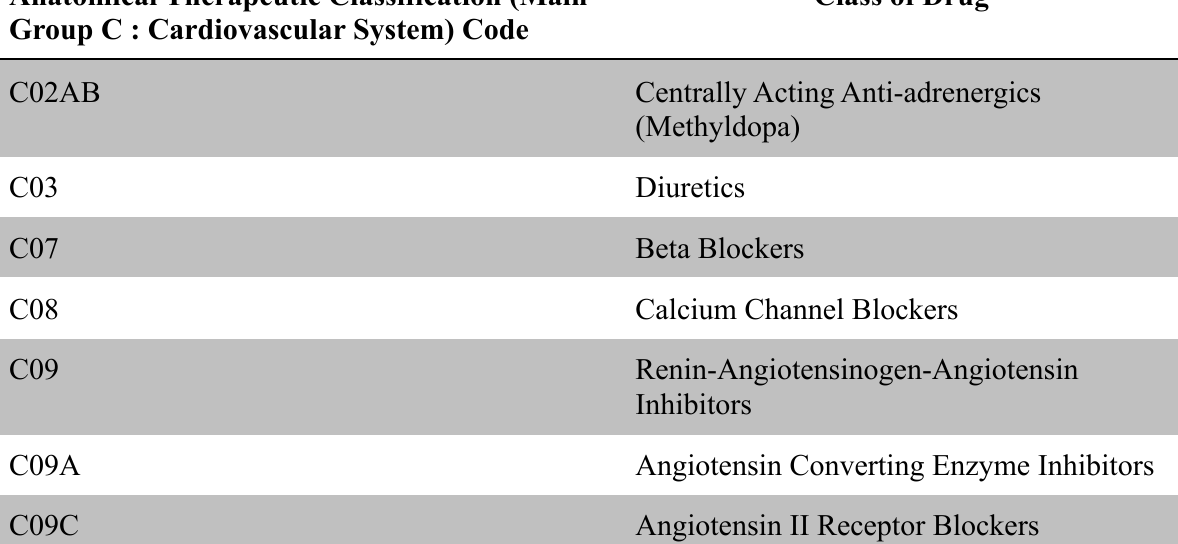
Table 2: Anatomical Therapeutic Classification of Antihypertensive Drugs Anatomical Therapeutic Classification (Main Group C : Cardiovascular System)